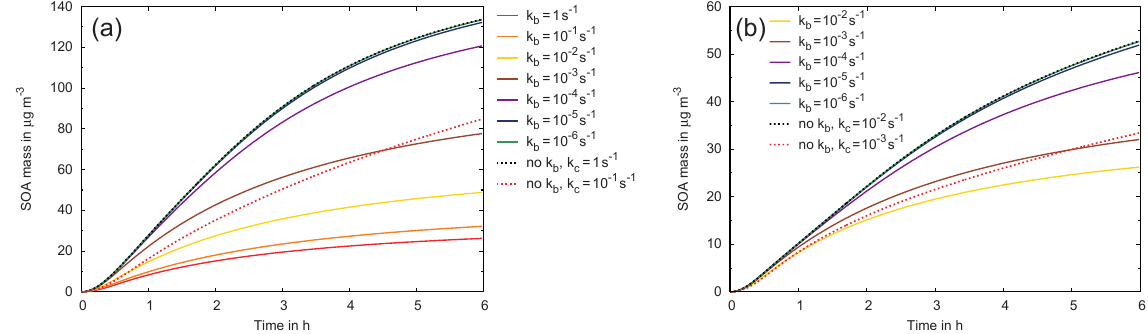
Figure 6. Simulated SOA mass including a chemical backward reaction in the particle phase for liquid ( D b = 10 − 12 m 2 s − 1 ) aerosol par- ticles (case 7 of Table 1) with (a) a fast chemical reaction in the particle-phase k c = 1s − 1 and (b) a reduced rate constant k c = 10 − 2 s − 1 , where backward reactions with different rate constants k b are additionally included. The reference simulations for the respective k c without backward reactions (indicated by “no k b ” in the key) are shown with dashed